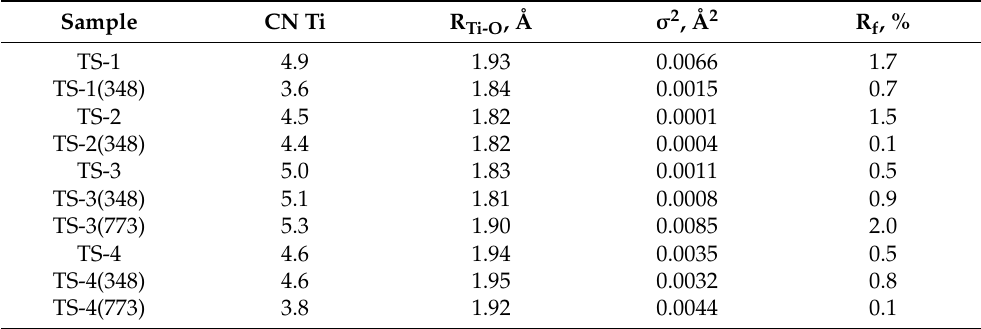
Table 14. Results of EXAFS modeling (R Ti-O , Å is the Ti-O interatomic distance, σ is the Debye–Waller factor, СN- coordination number, and R f is the convergence factor). The first coordination sphere (R = 1–2 Å) (Data from [33,34]).